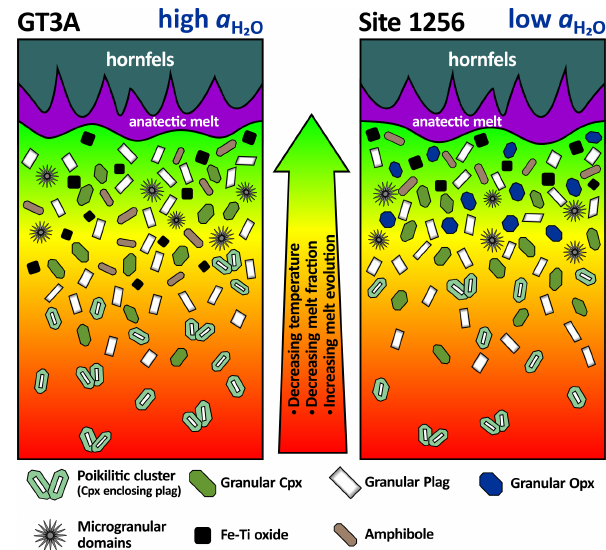
Figure 17. Schematic sketch of a cross-axis view illustrating the up- per part of the AML near the conductive boundary layer for the crys- tallization progress of the Oman GT3A lithologies (left) compared to the drilled core at IODP Site 1256 from the EPR (right). In the early stage of crystallization, both sites show sporadically poikilitic clusters followed by granular plagioclase and granular clinopyrox- ene. Olivine may join these assemblages at both sides, not shown in this sketch. Owing to the higher water activity in the GT3A sys- tem, here amphibole together with Fe–Ti oxides crystallized signif- icantly earlier compared to Site 1256. The microgranular domains, recorded from both sites, correspond to relics of stoped dike mate- rial from the AML roof. The crystallization of (late) orthopyroxene is restricted to the EPR site. For details see